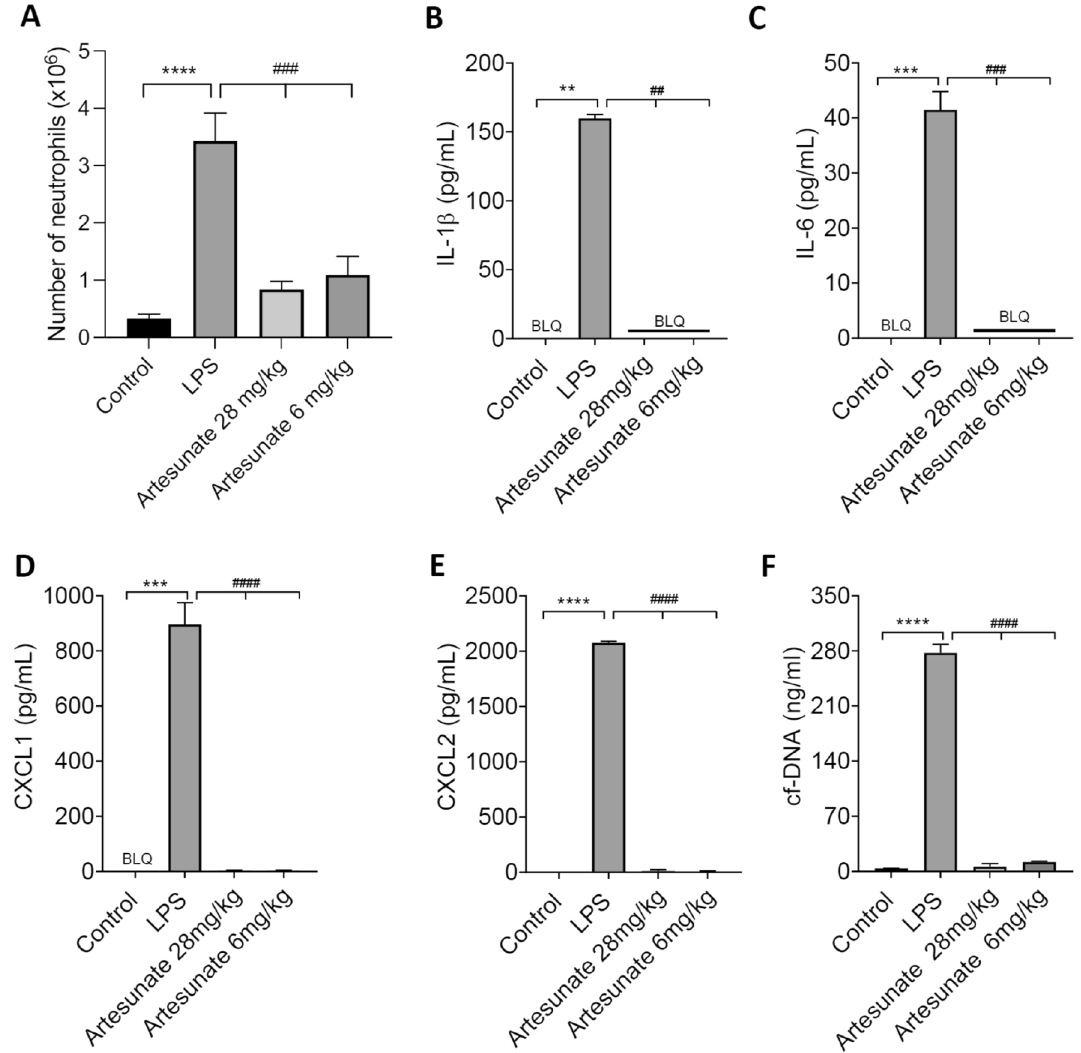
Figure 4. Artesunate suppresses neutrophil invasion, release of cytokines and release of NETs in response to infusion of LPS into lung. ( A ) Number of neutrophils recovered from broncho-alveolar lavage fluid (BALF), 5 h after infusion of LPS (300 ng each lung). LPS causes an influx of neutrophils that is suppressed by artesunate, delivered s.c. at 30 min before and at 90 and 210 min after injection of LPS. Each bar shows mean ± SEM from n = 4 mice. ( B – F ) Concentrations of IL-1β, IL-6, CXCL1, CXCL2 and NETs in BALF measured by ELISA and Pico-Green quantification as in Fig. 3, using same experimental protocol as in A. Increase in cytokine concentration and NET release induced by LPS was suppressed by artesunate. Each bar shows mean ± SEM from n = 3 mice. Statistical analysis: BLQ, below limit of quantitation; *p < 0.05; **P < 0.01; ***p < 0.001, ****p < 0.0001, LPS group compared with control group; #p < 0.05; ##p < 0.01; ###p < 0.001; ####p < 0.0001, LPS group compared with LPS plus artesunate group at same time point. ANOVA with Bonferroni post-hoc